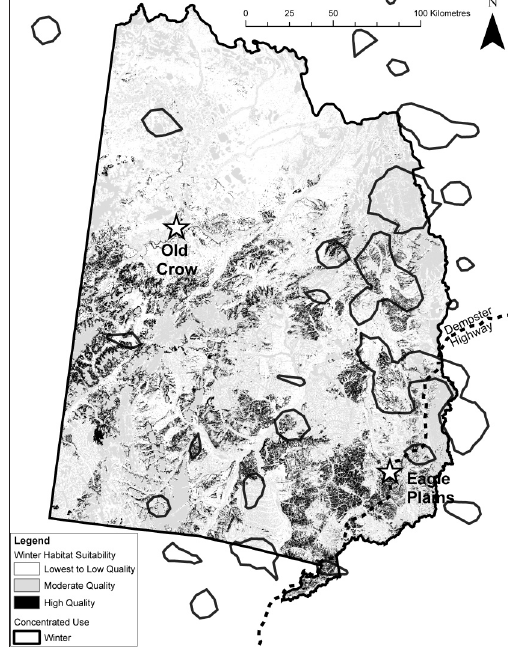
Fig. 3. Overlay of local knowledge and concentrated use areas for fall, winter and spring migration sea- sons. Important caribou range areas within the North Yukon Planning Region from August to May, as indicated by Old Crow residents, are shown as polygons (dark grey outline). Migration corridors (dark grey shading) and concentrated use areas (light grey shading) are also shown.